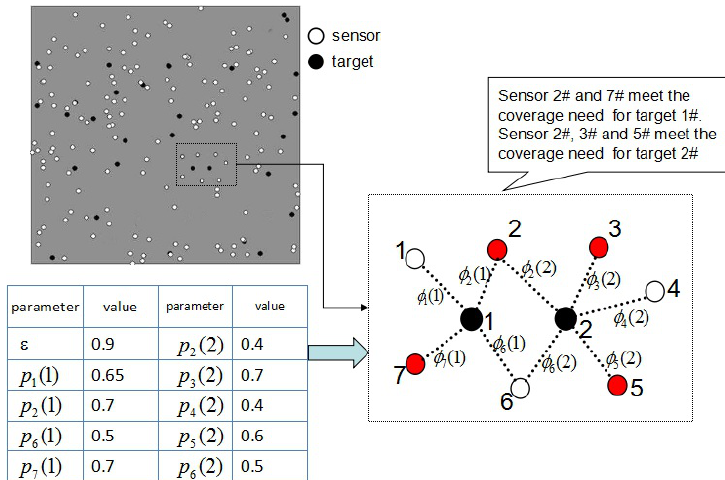
Figure 6. An example of the independent coverage set. The parameters are listed in the left table.